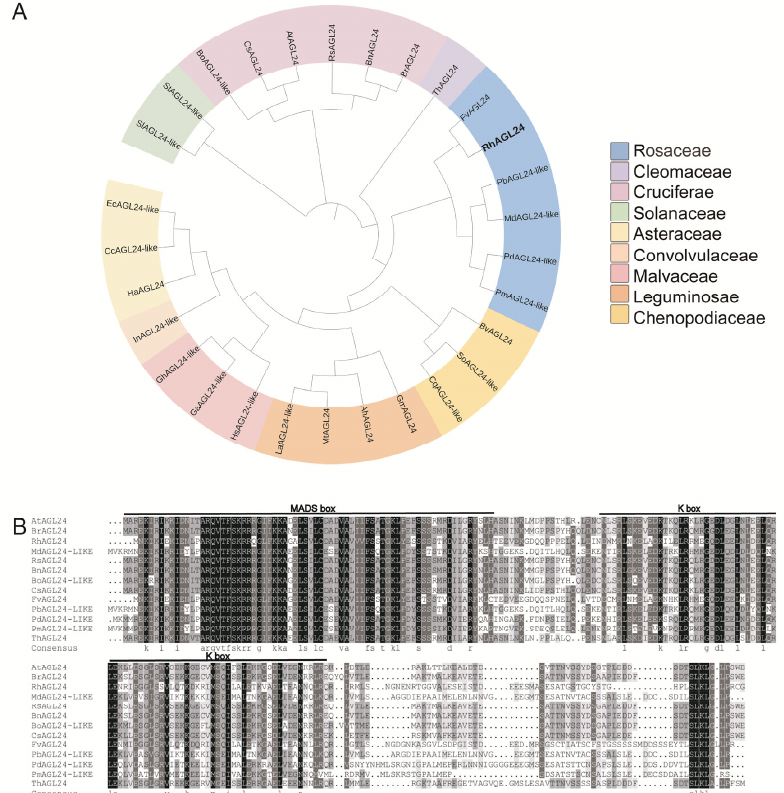
Figure 1. Conserved analysis of AGL24 protein sequence. ( A ) Phylogenetic evolutionary trees of AGL24 from different species; ( B ) comparison of multiple sequences of AGL24 proteins from different species. Conservative structures are represented above the alignment, and the amino acids that are the same for all species are represented underneath the alignment. At— Arabidopsis thaliana ; Br—